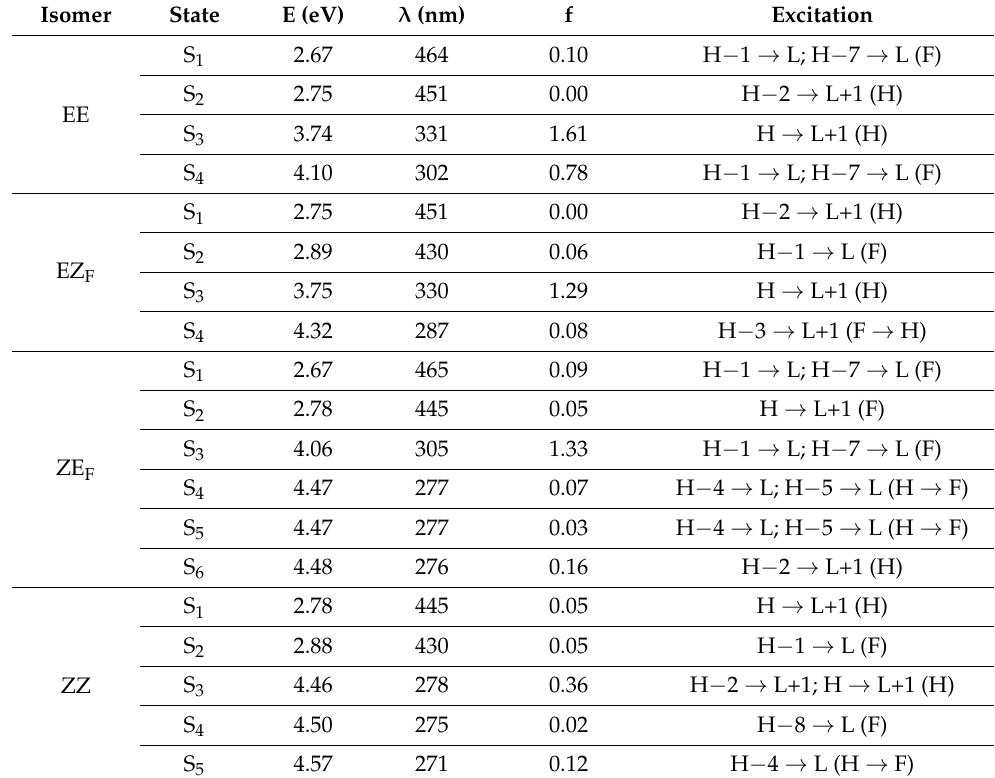
Table 1. Relevant lowest electronic excited states of the four E/Z stable isomers of dimer 1. Isomer